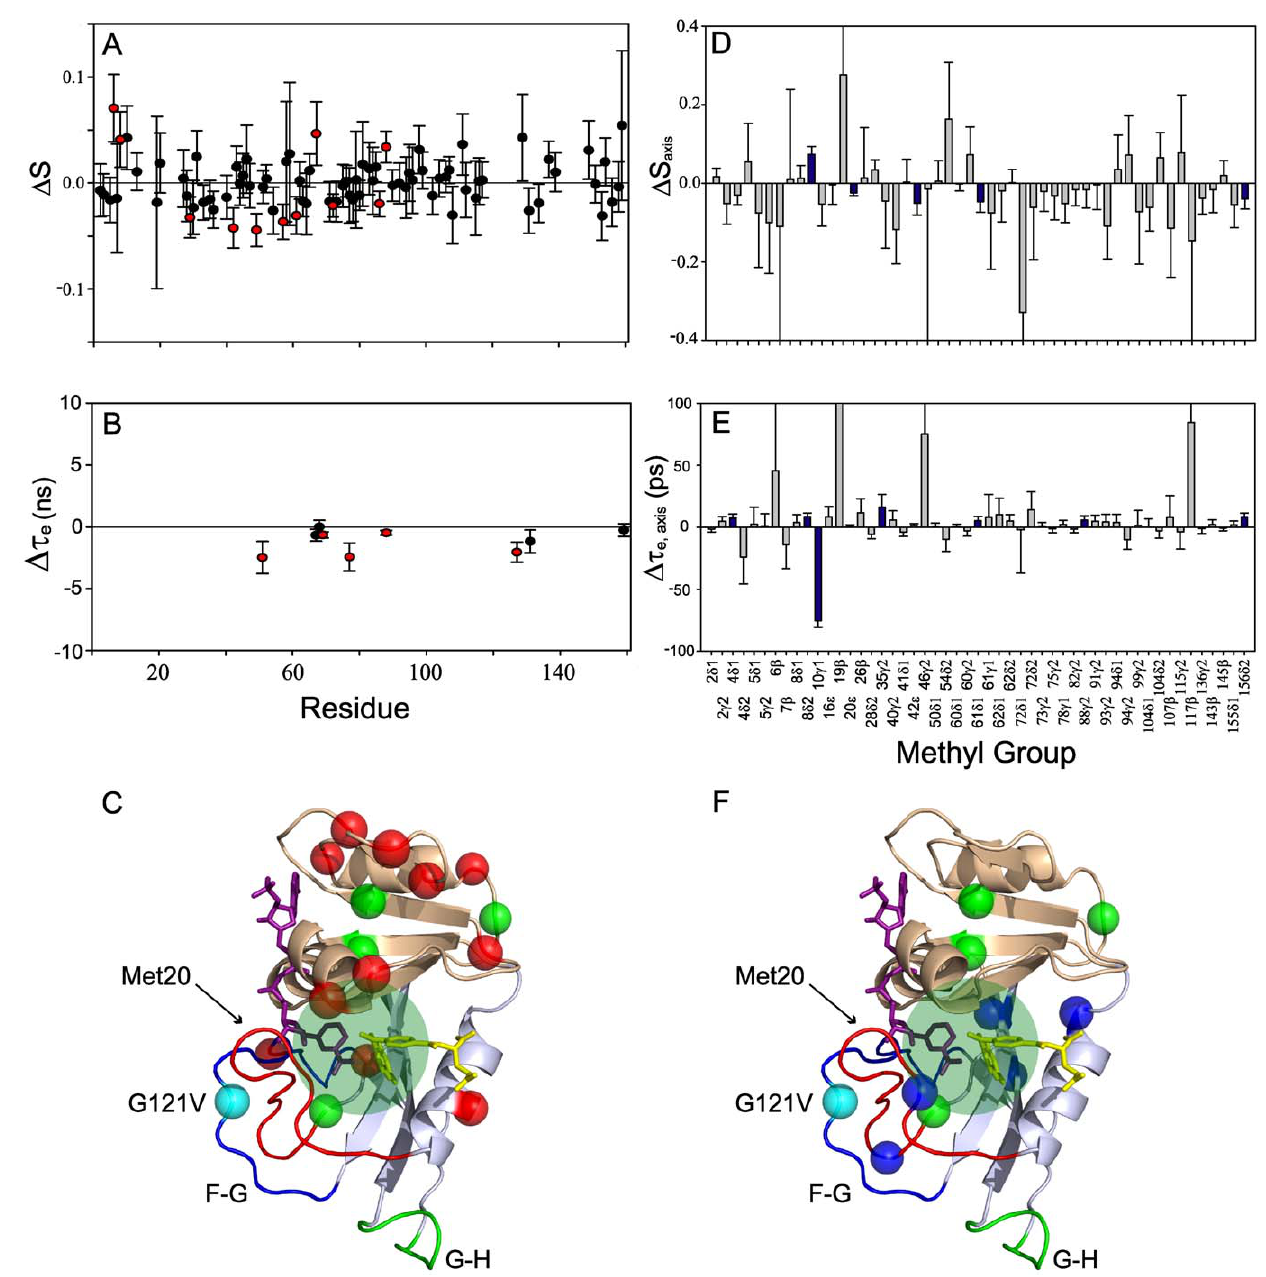
Figure 4. G121V dependent changes in backbone and side-chain dynamics on the ps-ns timescale. Changes in backbone S 2 (A) and t e (B) order parameters determined from 15 N relaxation experiments. Changes in side-chain S 2 axis (D) and t e, axis (E) order parameters determined from 2 H relaxation experiments. Plotted values were obtained by subtracting mutant (E G121V :NADPH:MTX) from wild-type (E:NADPH:MTX) parameters with significant changes ( . 1.5 s ) highlighted in red (backbone) and blue (side-chain). Significant changes are also mapped onto the structure using red spheres for backbone (C) and blue spheres for side-chain (F). Greens spheres denote residues that have significant changes in both backbone and side-chain order parameters. An area of 5 A˚ around the active site is highlighted in green.